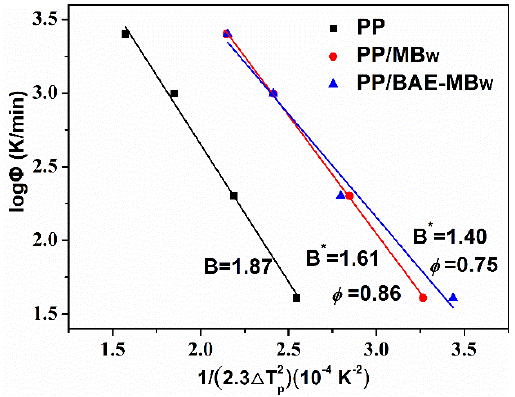
Φ vs. 1 / (2.3 ∆ T 2 Figure 7. Plots of log  vs. 1/(2.3 ∆ 𝑇 𝑝2 ) for PP and PP composites. Figure 7. Plots of log p ) for PP and PP